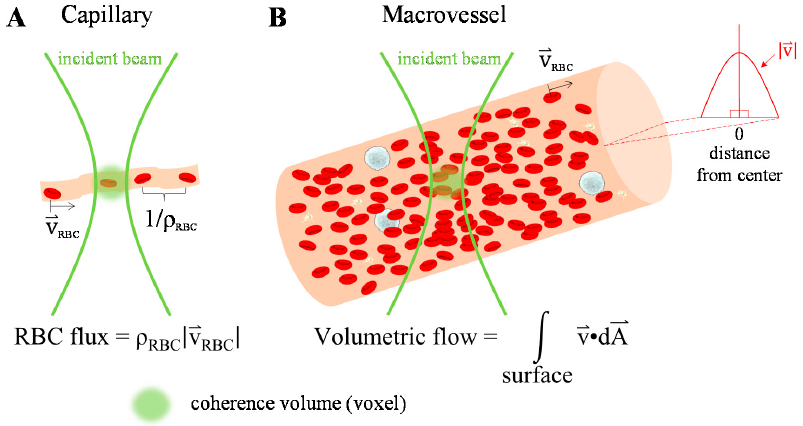
Figure 1. ( A ) Flow in capillaries (microvessels with diameters of <10 µ m) is single-file, usually with highly variable hematocrits that fall below systemic levels; ( B ) On the other hand, macrovascular flow often follows a blunted laminar profile at near-systemic hematocrits. Consequently, different approaches are required to quantify microvascular versus macrovascular hemodynamics via OCTA (Optical Coherence Tomography Angiography)